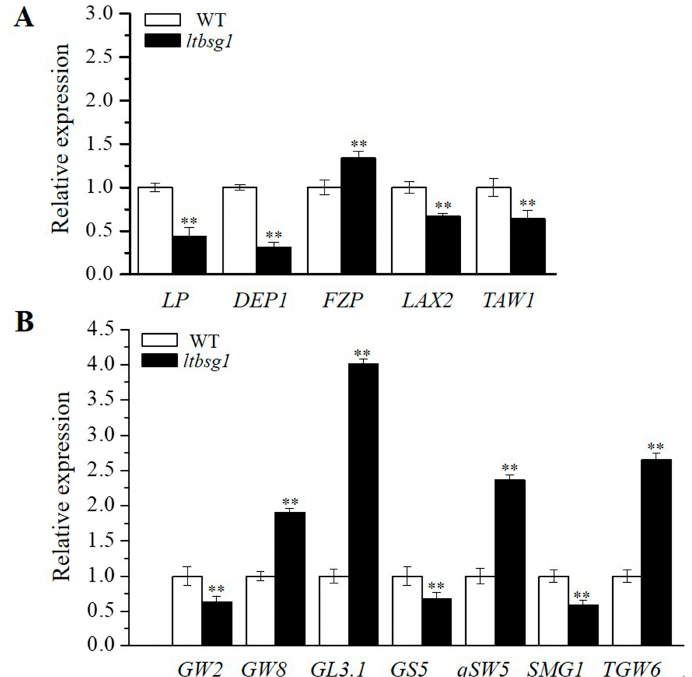
Figure 7. The expression of genes related to the panicle and the grain development in WT and mutant ltbsg1 . ( A ) The expression of genes related to the panicle development in young panicles of WT and mutant ltbsg1 ; ( B ) The expression of genes related to the grain size in young panicles of WT and mutant ltbsg1 . The rice OsActin gene was used as an internal control. Values represent the means ± SD of three biological replicates ( n = 3). ** p < 0.01.